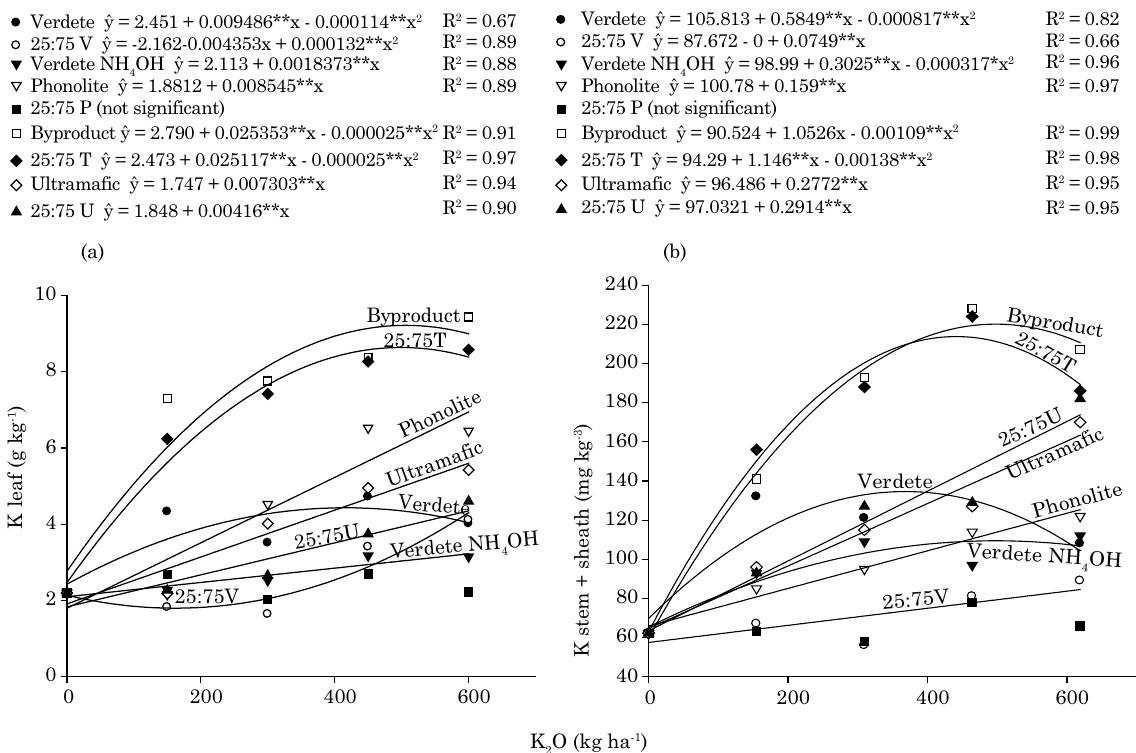
Figure 7. Potassium content in (a) leaf and (b) stem + sheath as affected by the treatments 60 days after